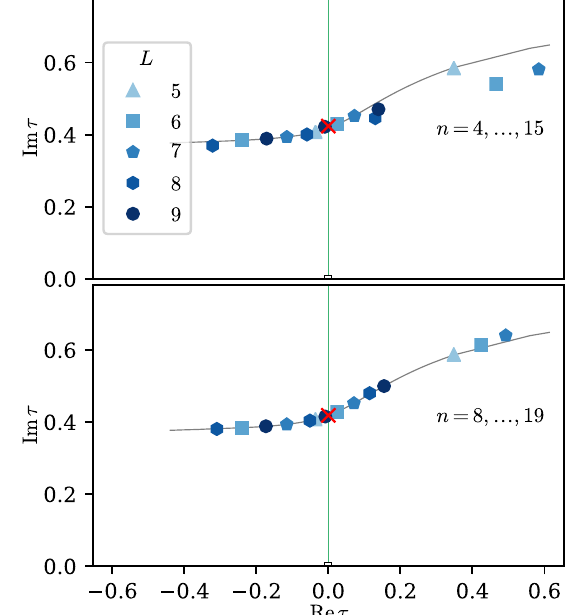
FIG. 5. Determination of the critical time from the initial energy fluctuations. Loschmidt zeros for the Heisenberg chain (11) are obtained from the energy fluctuations in the ground state of the model for J ¼ J z ¼ 3 B and D ¼ 0 at the initial time τ ¼ 0 , while the energy is determined by the postquench Hamiltonian with B ¼ 0 and D ¼ 4 . Here, J ¼ J 1 is the unit of energy and z ¼ inverse time. The zeros correspond to chains of lengths L ¼ 5 ; … ; 9 , and in the upper (lower) panel, we have extracted the zeros using energy cumulants of orders n ¼ 4 ; … ; 14 ( n ¼ 8 ; … ; 19 ). Importantly, the zeros converge to their exact positions with increasing cumulant orders as can be seen by comparing the panels. The gray line corresponds to the zeros in panel (c1) of Fig. 3, and the estimate of the critical time is indicated with a red